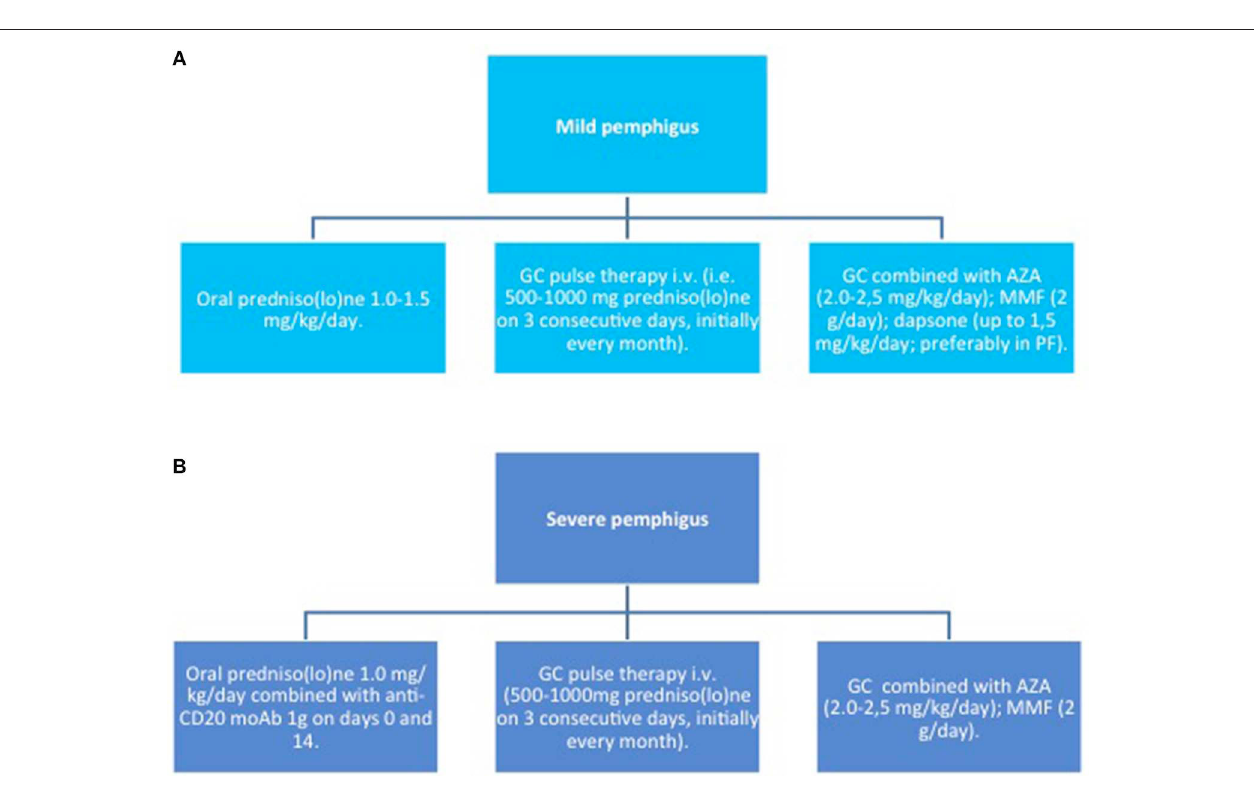
FIGURE 5 | Induction therapy in pemphigus. (A) mild pemphigus; (B) severe pemphigus. AZA, azathioprine; GC, glucocorticoids; MMF, mycophenolate mofetil; moAb, monoclonal